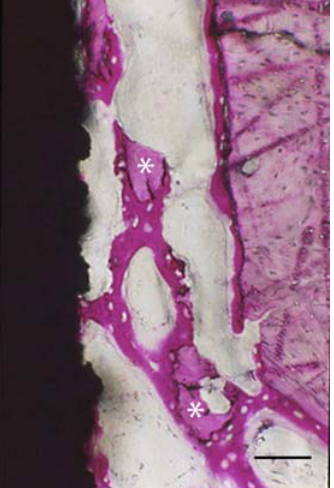
FIGURE 2. LM image of TPS screw 2 weeks after surgery. Newly formed bone trabeculae and osteoid tissue with osteoblasts are visible both rising from the host bone and holding on to the rough implant surface. Small host bone chips (*), occasionally arisen from the action bur during cavity preparation, are partially enclosed in the new bone trabeculae. Bar = 100 µm